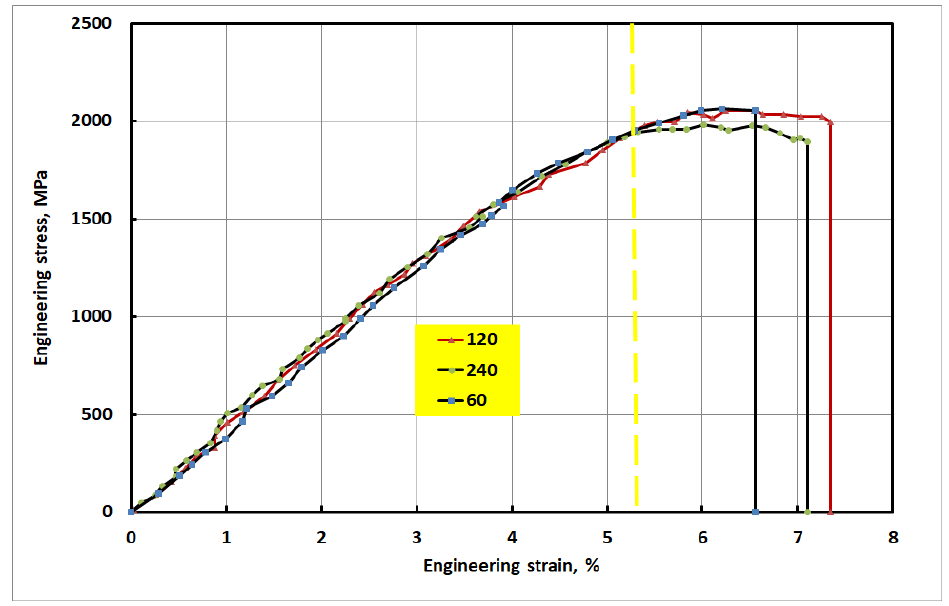
Figure 7. Stress strain curve of M9.8 WQ/aged samples with different holding time 60 min, 120 min and 240 min.